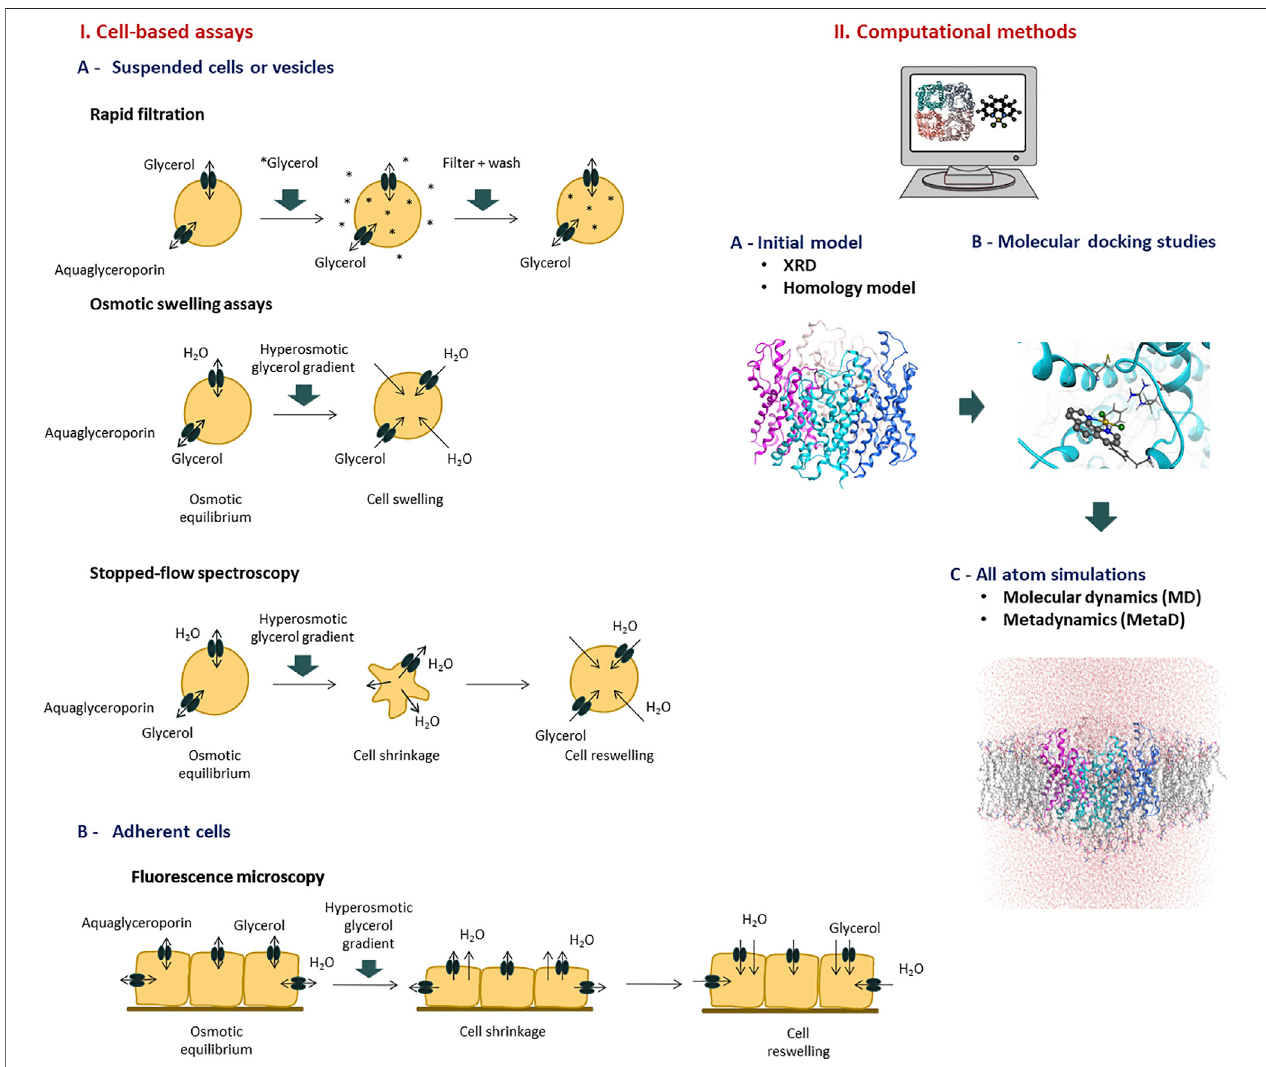
FIGURE2| Methodstoevaluateaquaglyceroporinsfunctionandscreenpotentialmodulators.RepresentativeassaysofI)Cellbasedassays,andII)Computational methods.